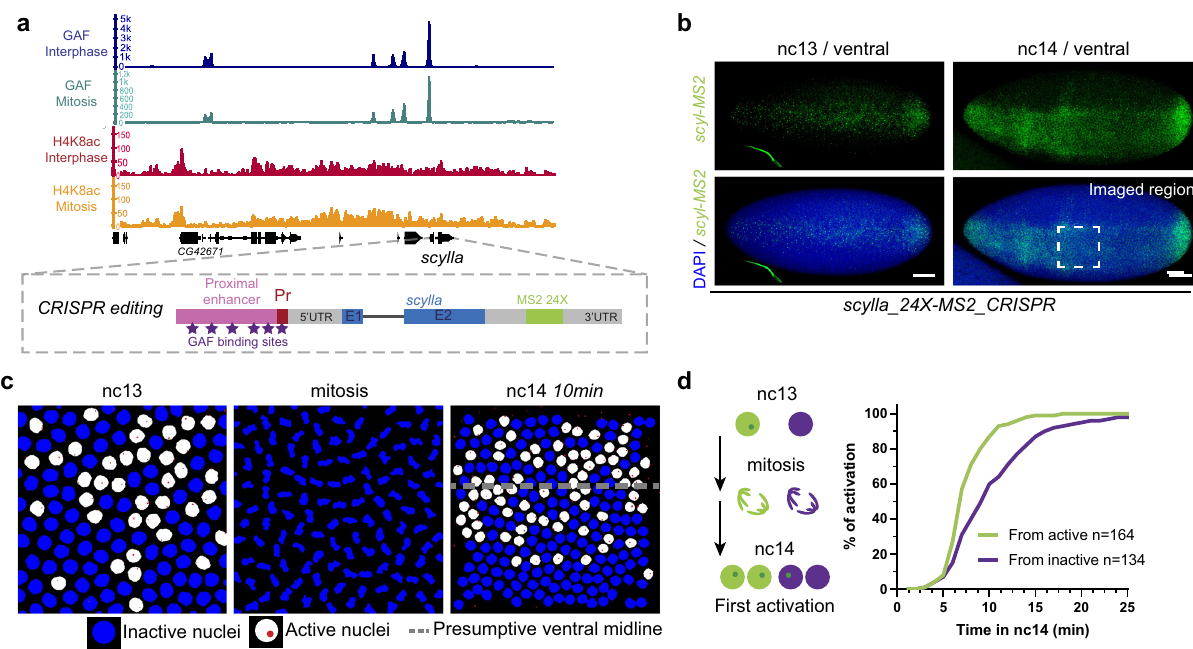
Fig. 4 scylla gene harbors a transcriptional memory across mitosis. a (Top) Genome browser image of interphase and mitotic GAF (dark blue and turquoise) and H4K8ac (red and orange) ChIP-seq signal at the scyl locus. (Bottom) Schematic of the 24X-MS2 tagging strategy of the scyl locus by CRISPR editing. A unique guide RNA sequence was designed to insert the 24X-MS2 repeats by homologous recombination, at 70 bp from the stop codon. b Maximum intensity projected Z-planes of confocal images from smiFISH with MS2 probes (green) counterstained with DAPI (blue) of scylla_24X- MS2_CRISPR/ + embryos in nc13 and nc14. Scale bars are 50 µ m. The dashed box represents the region considered for live imaging experiments. c Snapshots from a representative false-colored movie of scylla_24X-MS2_CRISPR/ + embryo carrying MCP-eGFP , His2Av-mRFP . Active nuclei are represented in white and inactive nuclei in blue. Transcriptional sites are false-colored in red. The dashed line represents the presumptive ventral midline. d Quanti fi cation of transcriptional memory for scyl gene. Left panel: schematic of the two populations of nuclei studied; those derived from active (in green) and those from inactive nuclei (purple). Right panel: cumulative activation of the fi rst activated nuclei coming from active nuclei (green) and from inactive (purple). n = number of analyzed pooled nuclei from four movies of four independent